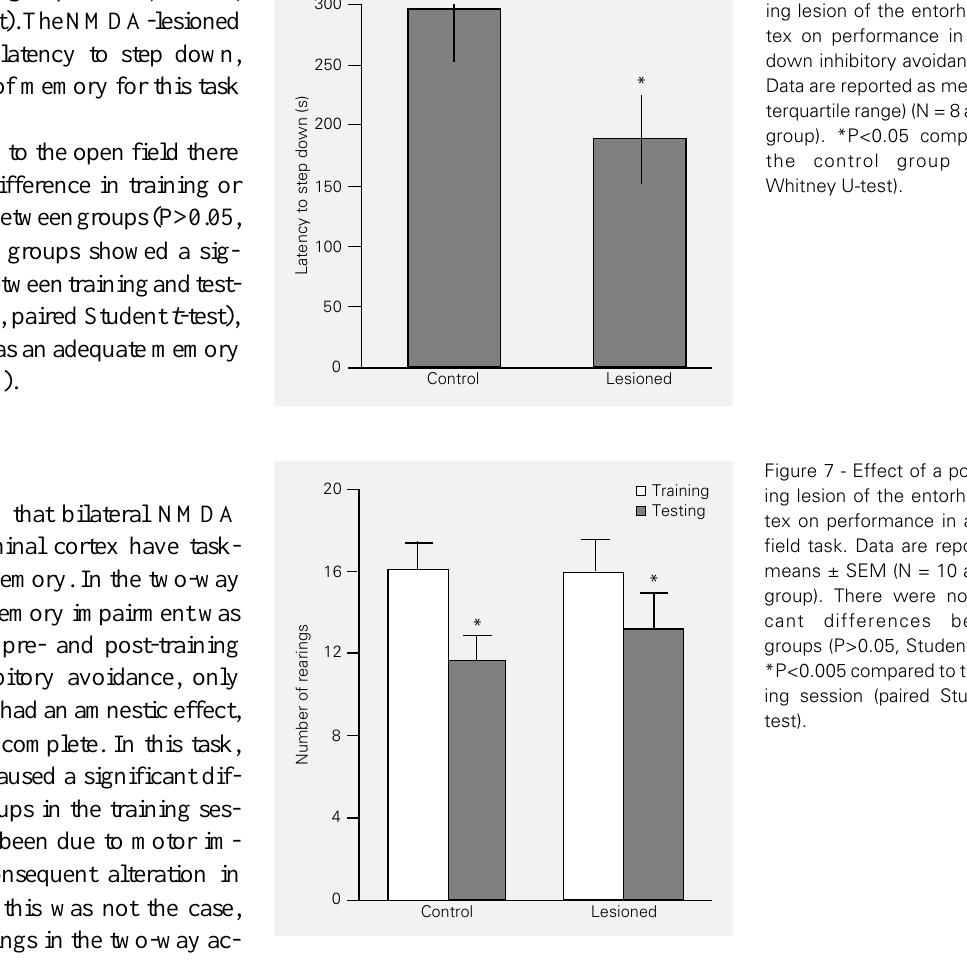
Figure 6 - Effect of a post-train- ing lesion of the entorhinal cor- tex on performance in a step- down inhibitory avoidance task. Data are reported as median (in- terquartile range) (N = 8 animals/ group). *P<0.05 compared to the control group (Mann- Whitney U-test).